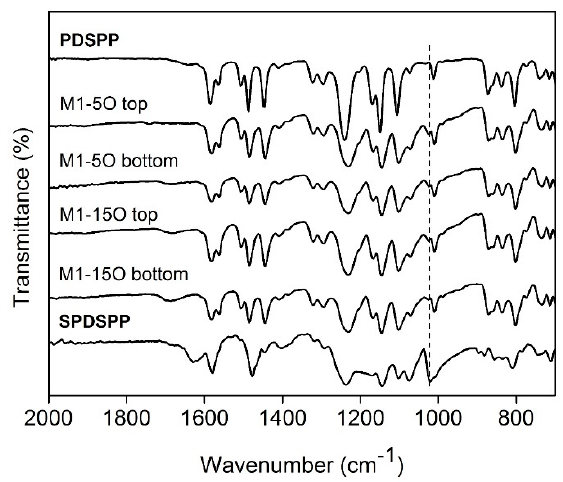
Figure 3. ATR-FTIR spectra of the membranes M1-5O and M1-15O on top and bottom surfaces. For comparison, ATR-FTIR spectra of the PDSPP and SPDSPP homopolymers are shown.